Question: In one sentence, what is this figure communicating?
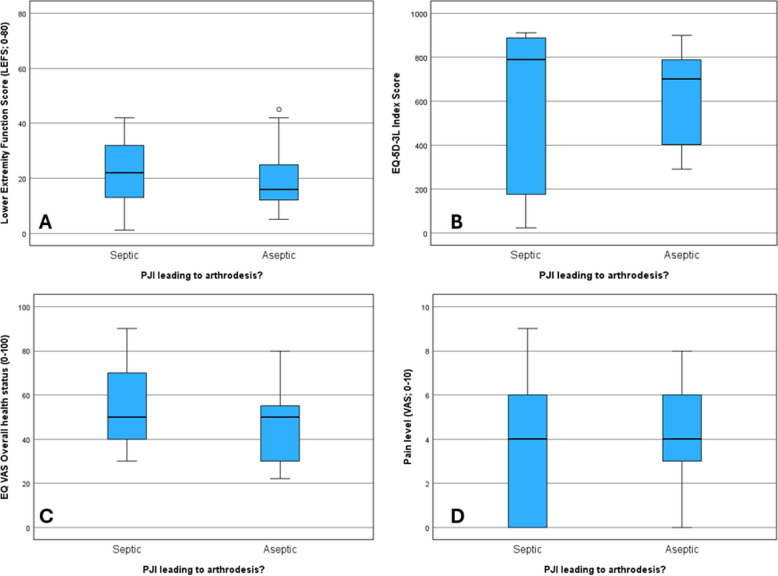
Answer: Comparison between septic and aseptic arthrodesis regarding the functional outcome, quality of life and overall health status. A mean (SD) Lower Extremity Function Score (LEFS): septic: 22.7 (12.1)/aseptic: 20.0 (12.1), p = 0.542; ( B ) mean (SD) EQ-5D-3L index score: septic: 0.595 (0.341)/0.635 (0.230), p = 0.711; ( C ) mean (SD) EQ VAS overall health status: septic: 54.9 (18.1)/45.9 (17.4), p = 0.183; ( D ) mean (SD) pain level (visual analogue scale 0–10): septic 3.7 (3.1)/4.2 (2.4), p = 0.621